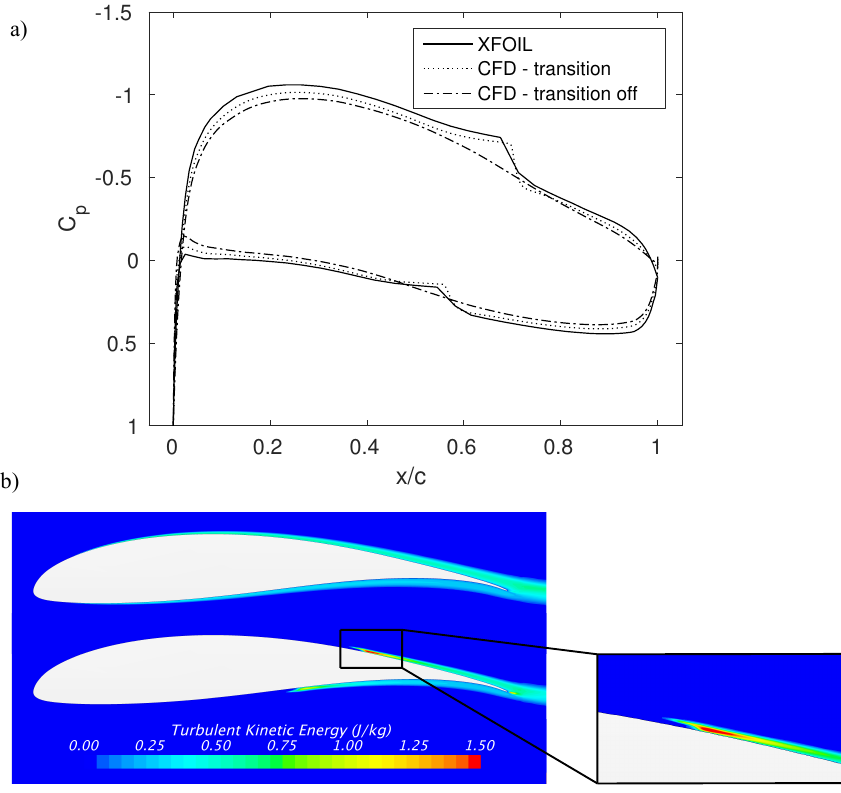
Figure 10. Two-dimensional results of the airfoil FX63-137: ( a ) pressure coefficient distribution at zero degrees angle of attack; ( b ) comparison of turbulent kinetic energy (upper airfoil: computational fluid dynamics (CFD) without transition; lower airfoil: CFD with